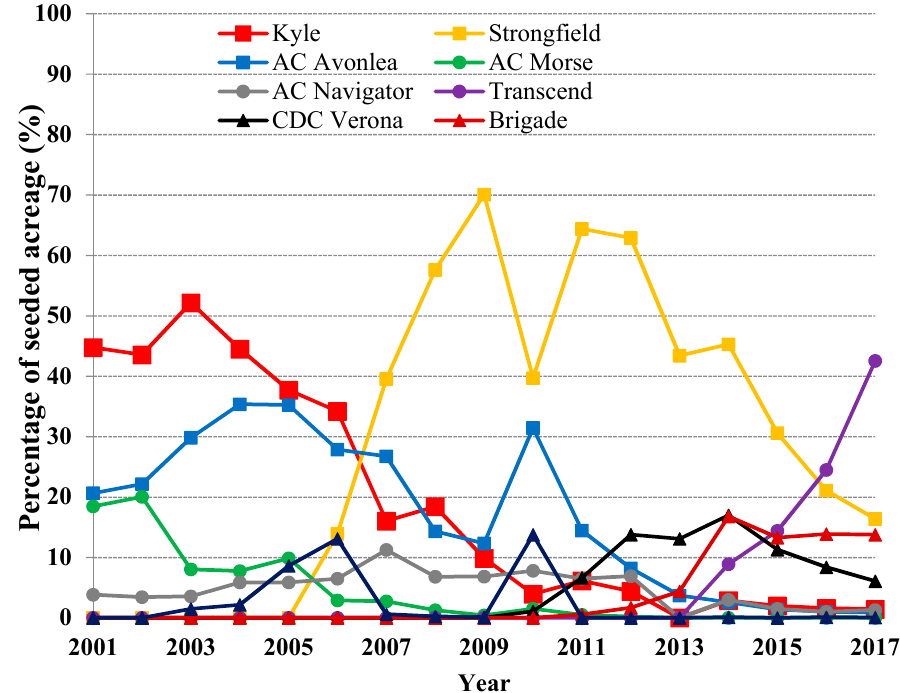
Figure 12. Percentage of seeded areas by the major Canadian durum wheat cultivars during 2001–2017 (Source: Provincial crop insurance data compiled with Canadian Grain Commission).